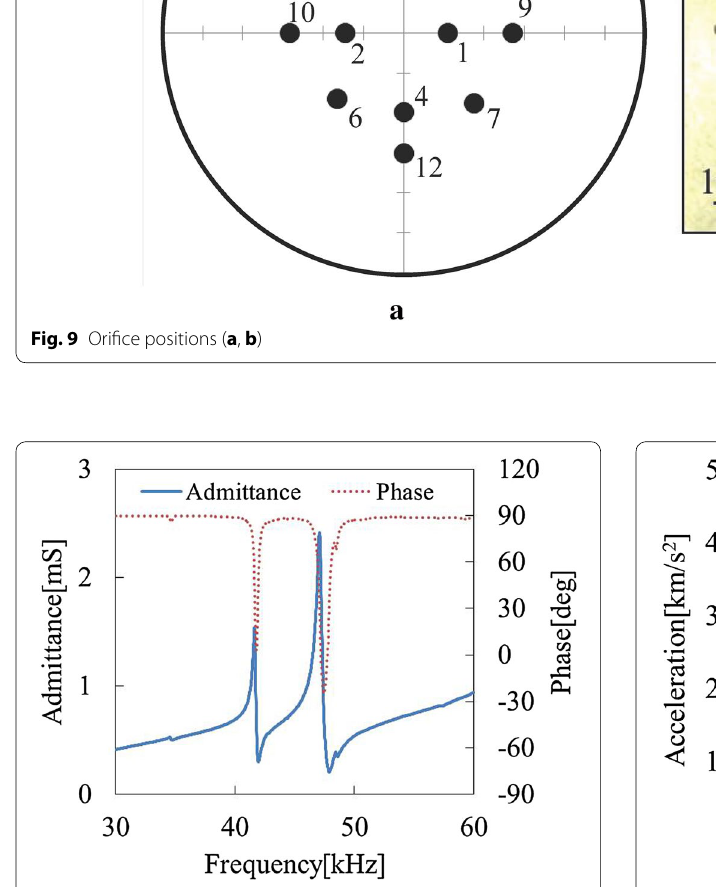
Fig. 10 Relationship between admittance of the prototype, phase and frequency